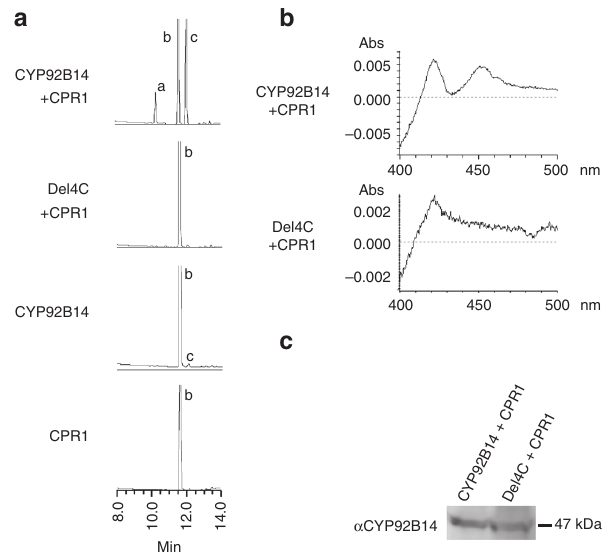
Fig. 3 CYP92B14 biosynthesizes (+)-sesamolin and (+)-sesaminol from (+)-sesamin in vitro. a Microsome fractions prepared from a series of transformed yeasts were subjected to enzyme assays using (+)-sesamin as a substrate. a: (+)-sesaminol; b: (+)-sesamin; c: (+)-sesamolin. b CO- difference spectra of microsome fractions expressing CYP92B14 .